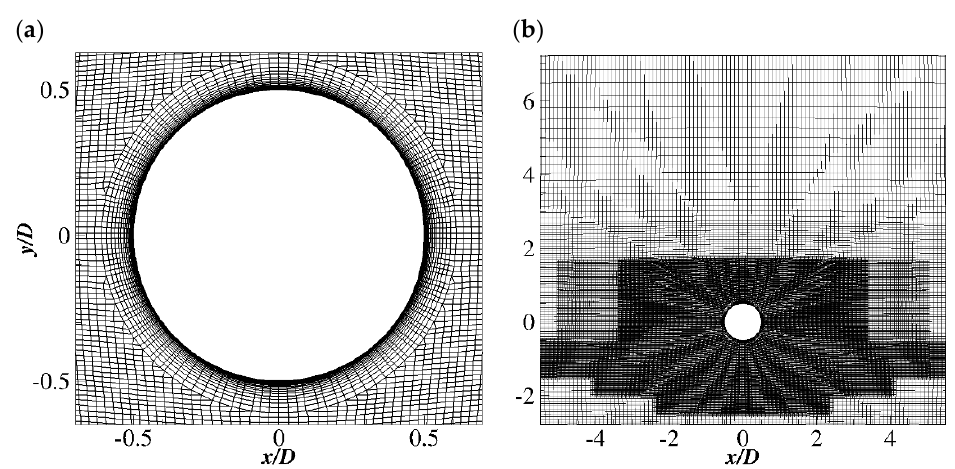
Figure 3. The time-histories of ( a ) (cid:1829) (cid:3031) and ( b ) (cid:1829) (cid:3039) for different meshes: Mesh 1: blue; Mesh 2: black; Mesh 3: red.